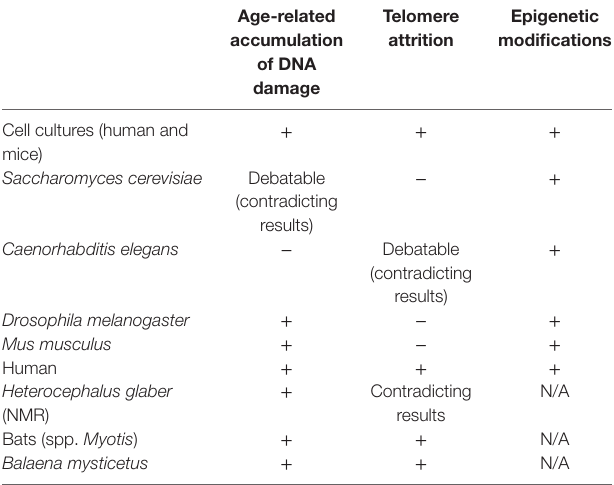
TABLe 1 | Evidence for correlation between DNA damage accumulation, telomeres attrition and epigenetic alterations, and aging in In Vitro , In Vivo , and aging-like human syndromes